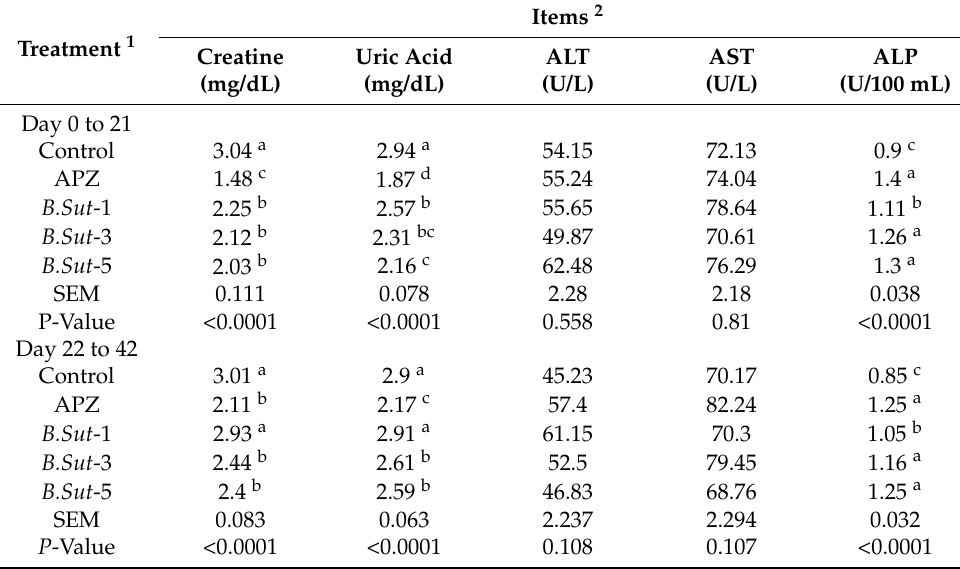
Table 4. Effect of the addition of Bacillus subtilis into broiler diets on serum kidney and liver functions and alkaline phosphates of broiler chickens at 21st and 42nd days